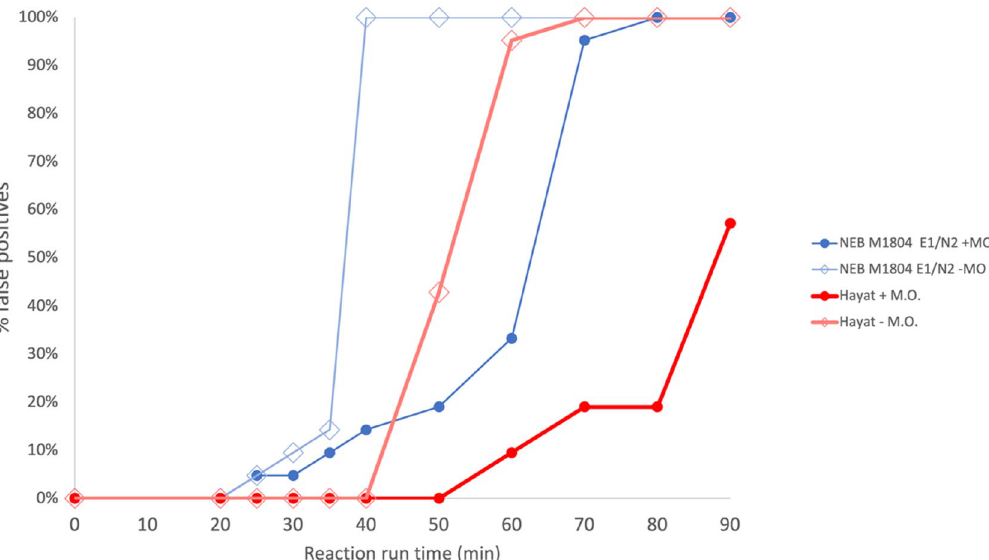
Figure 1. The presence of mineral oil markedly reduces the rate of production of false positive RT-LAMP reactions. Two assay chemistries were compared: NEB WarmStart Colorimetric LAMP with UDG (M1804) and Hayat Rapid Colorimetric & Fluorometric One Step LAMP SARS-CoV-2 Test Kit, each set up with and without 15 μl mineral oil overlay. Twenty-one identical replicate negative control reactions were set up per condition with a single saliva sample negative for SARS-CoV-2 diluted in VTM and AviSal at a ratio of 1:1:2 and heat inactivated for 10 min at 95 °C. The sample was added to give 5% (NEB) and 3.75% (Hayat) final concentrations of crude saliva in a 25 μl reaction volume. + M.O. with mineral oil overlay; − M.O. without mineral oil. In a typical 30-min reaction runtime, only Hayat chemistry resulted in no false positives and 100% specificity. For the NEB chemistry, false positives were observed after 20 min, even with a mineral oil overlay. Mineral oil overlay markedly reduces the false positive